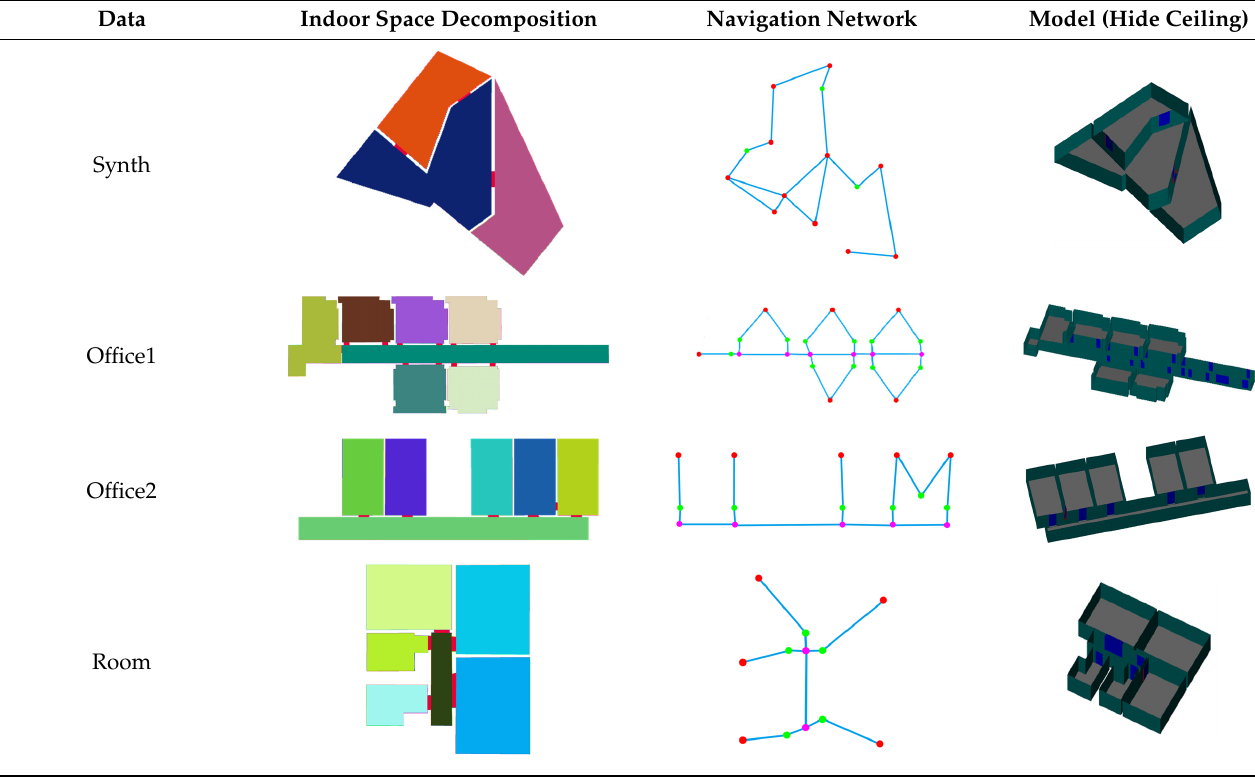
Figure 14. Schematic diagram of the parameters of Equations (10) and (11).